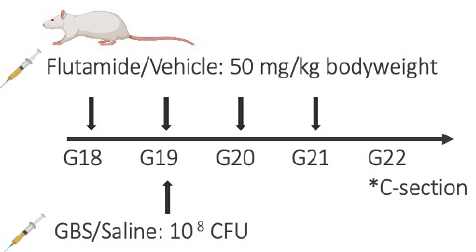
Figure 6. Timeline of injections and C-section of dams from G18 to G21.